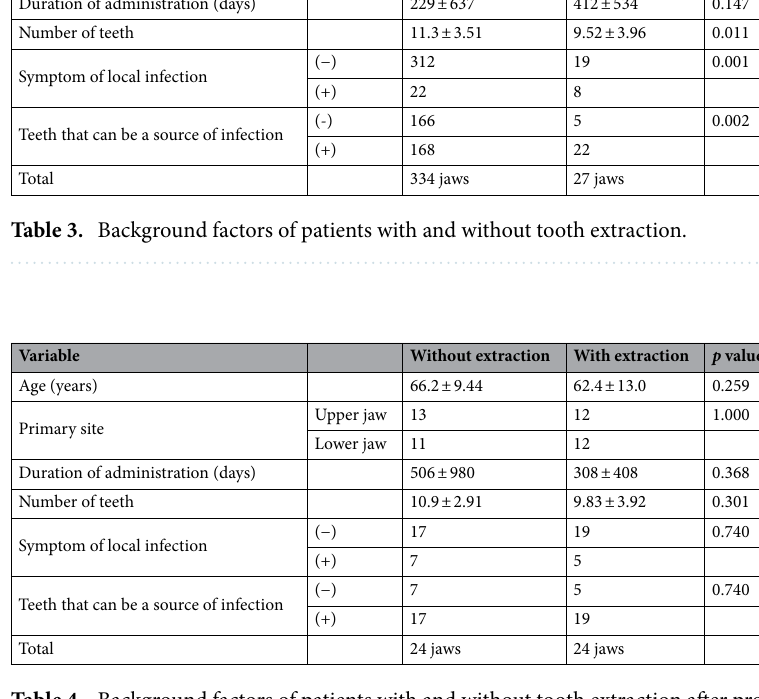
Table 4. Background factors of patients with and without tooth extraction after propensity score matching.